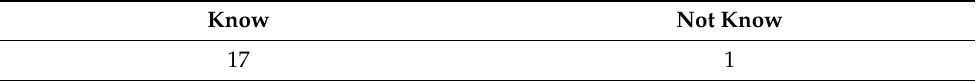
Table 1. Resident awareness of the Hiraenoki Reconstruction Committee (HRC) activities. Know Not Know 17